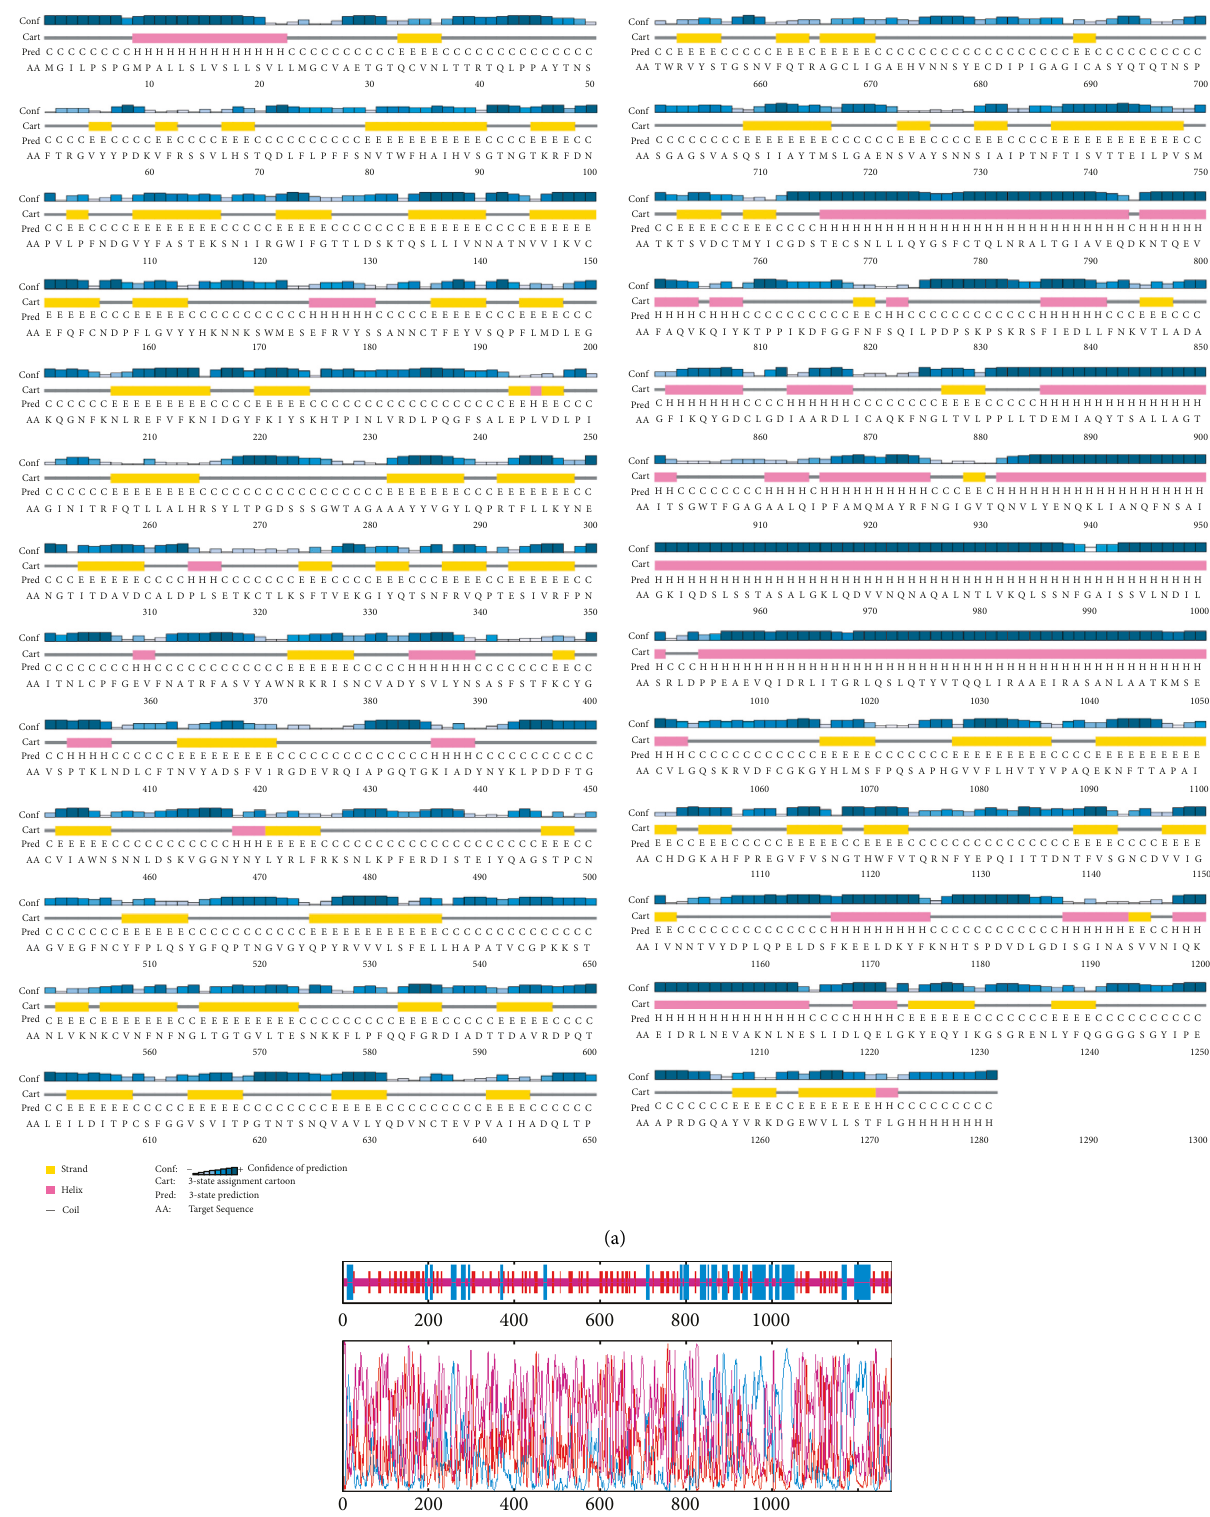
Figure 1: Secondary structure prediction of SARS-CoV-2-SG using (a) PSIPRED and (b) GOR